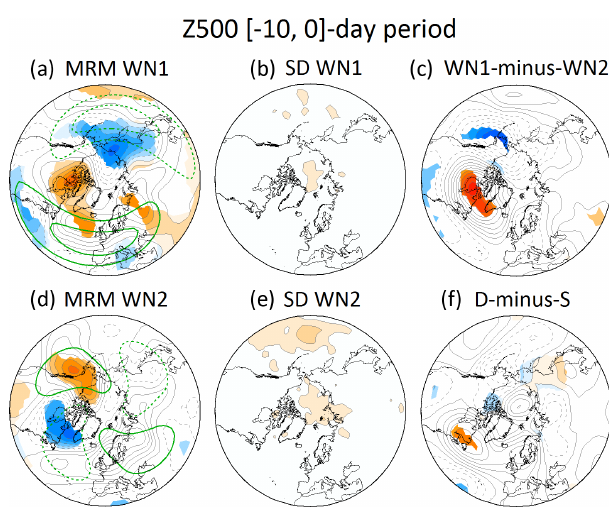
Figure 7. (a) MRM of WN1 SSW-based composites of 500hPa geopotential height anomalies (contour interval 20m) in the [ − 10, 0]d period before events for the comparison period (1979–2012). Only statistically significant anomalies at the 95% confidence level of the same sign (Monte Carlo test) in at least 66.7% of all reanaly- ses are shaded. (b) Standard deviation of the reanalyses with respect to the MRM divided by the square root of the number of reanaly- ses for WN1 SSWs (contour interval is 1gpm). (c) Same as (a) but for the WN1 SSW minus WN2 SSW differences in MRM com- posites of 500hPa geopotential height anomalies. Shading denotes statistically significant differences at the 95% confidence level in at least 66.7% of all reanalyses (Monte Carlo test). (d, e) Same as (a) and (b) but for WN2 SSWs, respectively. (f) Same as (c) but for displacement ( D ) minus split ( S ) events. Green contours in (a) and (d) show the MRM climatological WN1 and WN2 of 500hPa geopotential height from November to March, respectively (con- tours: ± 40 and ±